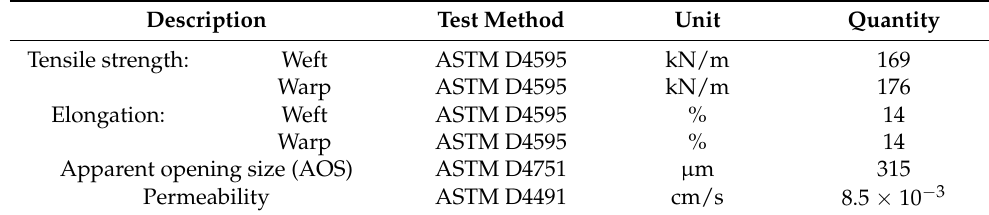
Table 2. Properties of the woven polyester